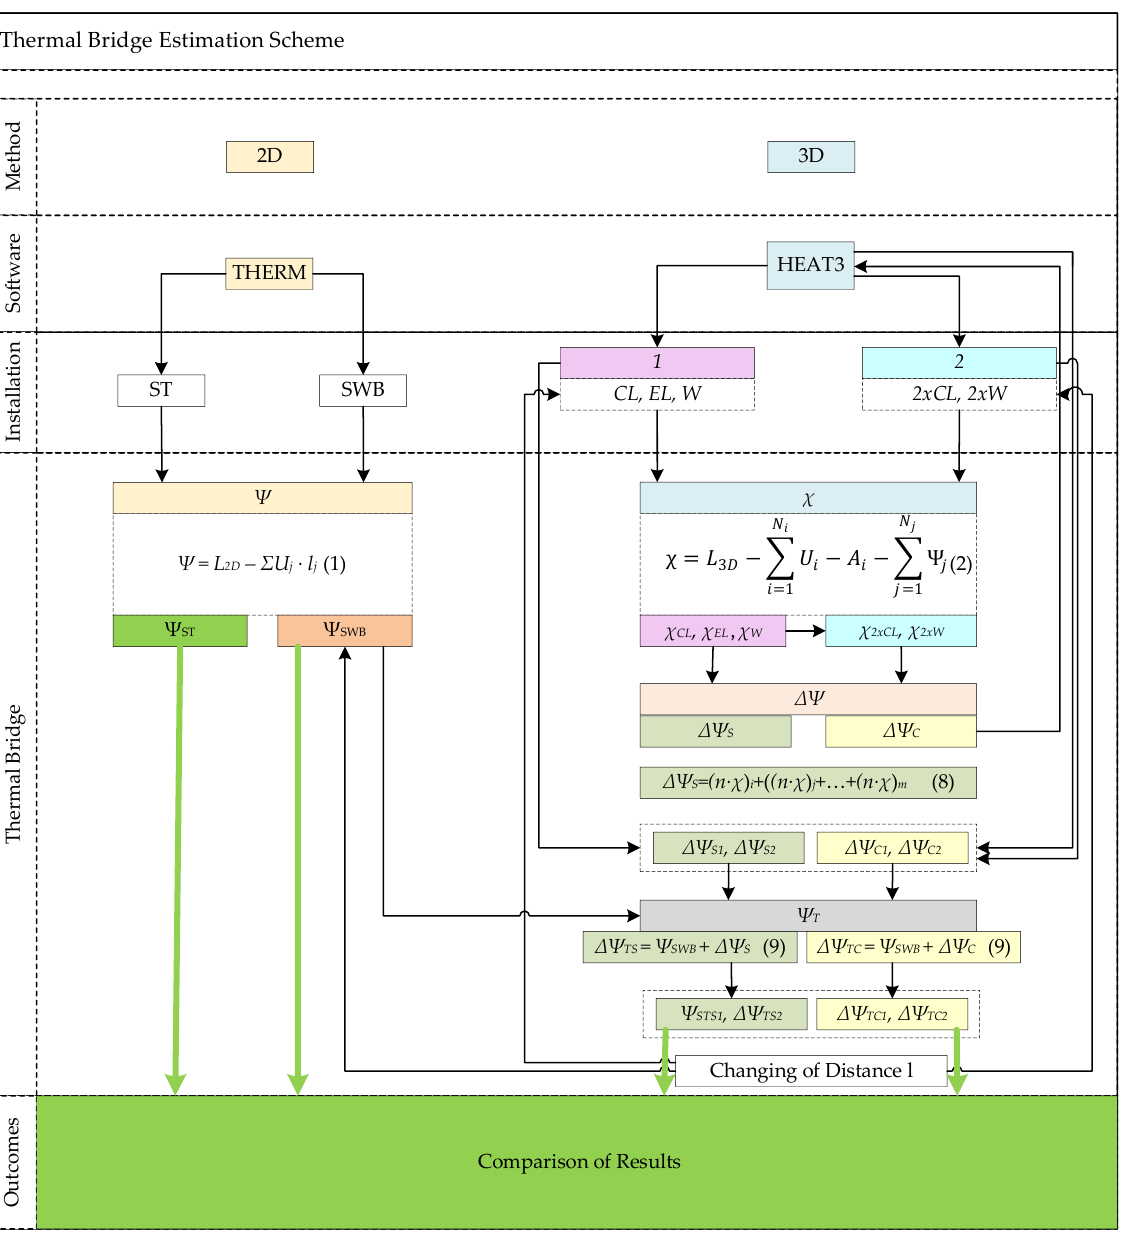
Figure 5. Thermal bridge estimation scheme (prepared by the authors based on [35]).